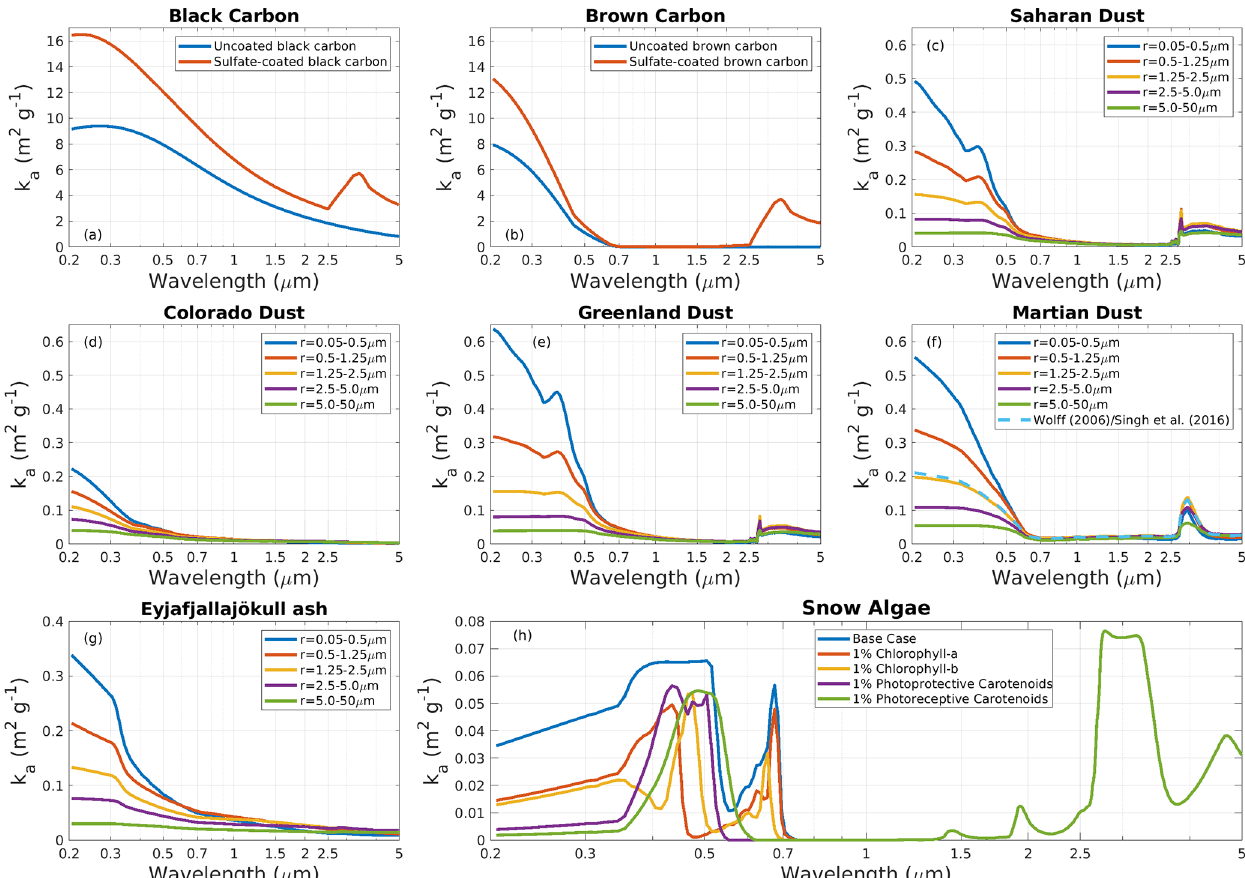
Figure 3. Spectral mass absorption cross sections ( k a ) of the black carbon (a) , brown carbon (b) , four types of mineral dust (c–f) , and volcanic ash (g) species included in the SNICAR-ADv3 optical property library, along with a small subset of the snow algae properties (h) . The “base case” algae consists of dry cell mass fractions of 1.5% chlorophyll a , 0.5% chlorophyll b , 5% photoprotective carotenoids, and 0% photoreceptive carotenoids. Single-pigment scenarios with 1% mass fraction are shown in the other curves. The mean cell radius in all cases is 10µm. Note that k a is normalized to the mass of the entire cell, which is 78% water by volume. The large k a values for snow algae at λ > 2 . 5µm (exhibited in all curves) are due to absorption by